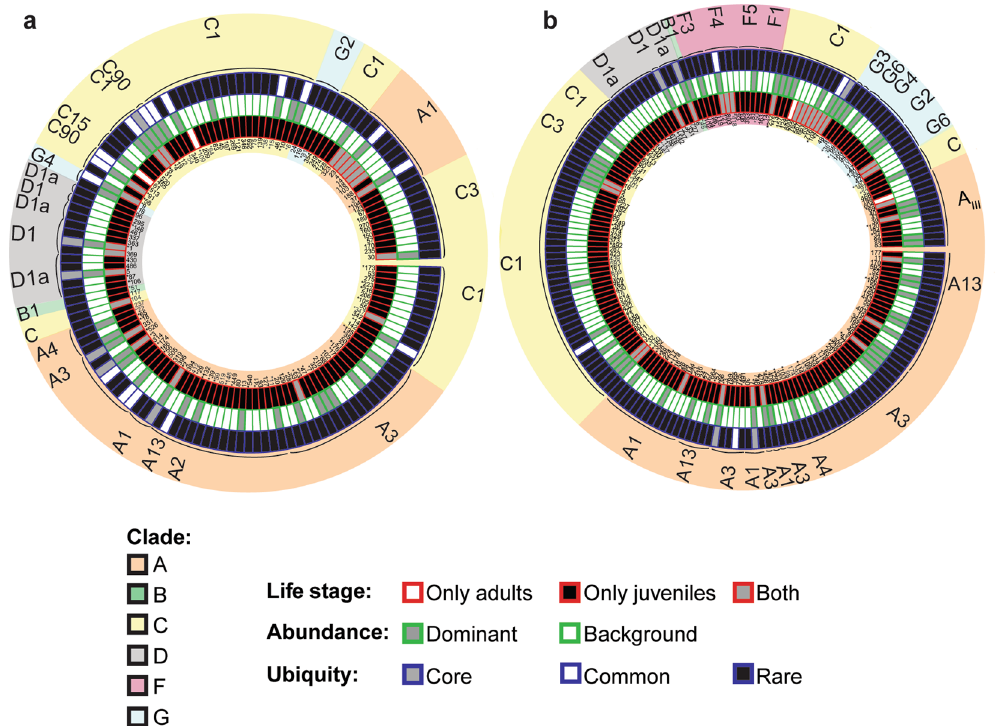
Figure 1. Circular trait plots of 261 Symbiodinium ITS-2 OTUs retrieved from Acropora tenuis juveniles and adults in 2012 ( a ) and 2013 ( b ). Plots include only those OTUs that were retrieved from three or more samples (134/422 OTUs in 2012 and 181/568 OTUs in 2013). Concentric circles from innermost to the outermost position represent OTUs present: (1) life-stage, (2) normalized abundance (principal: > 0.01%, background < 0.01%), and (3) ubiquity (core: > 75% of samples, common: 25–75%, rare: < 25%). OTU identity with an asterisk indicates it was retrieved in both years. Semi-transparent backgrounds represent clade designations of individual OTUs. See Supplementary Table S8 for full taxonomic